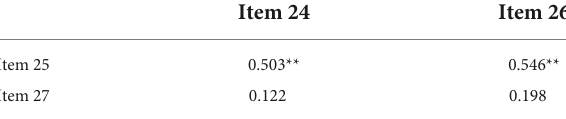
TABLE 8 Correlations between teachers’ beliefs about teacher support